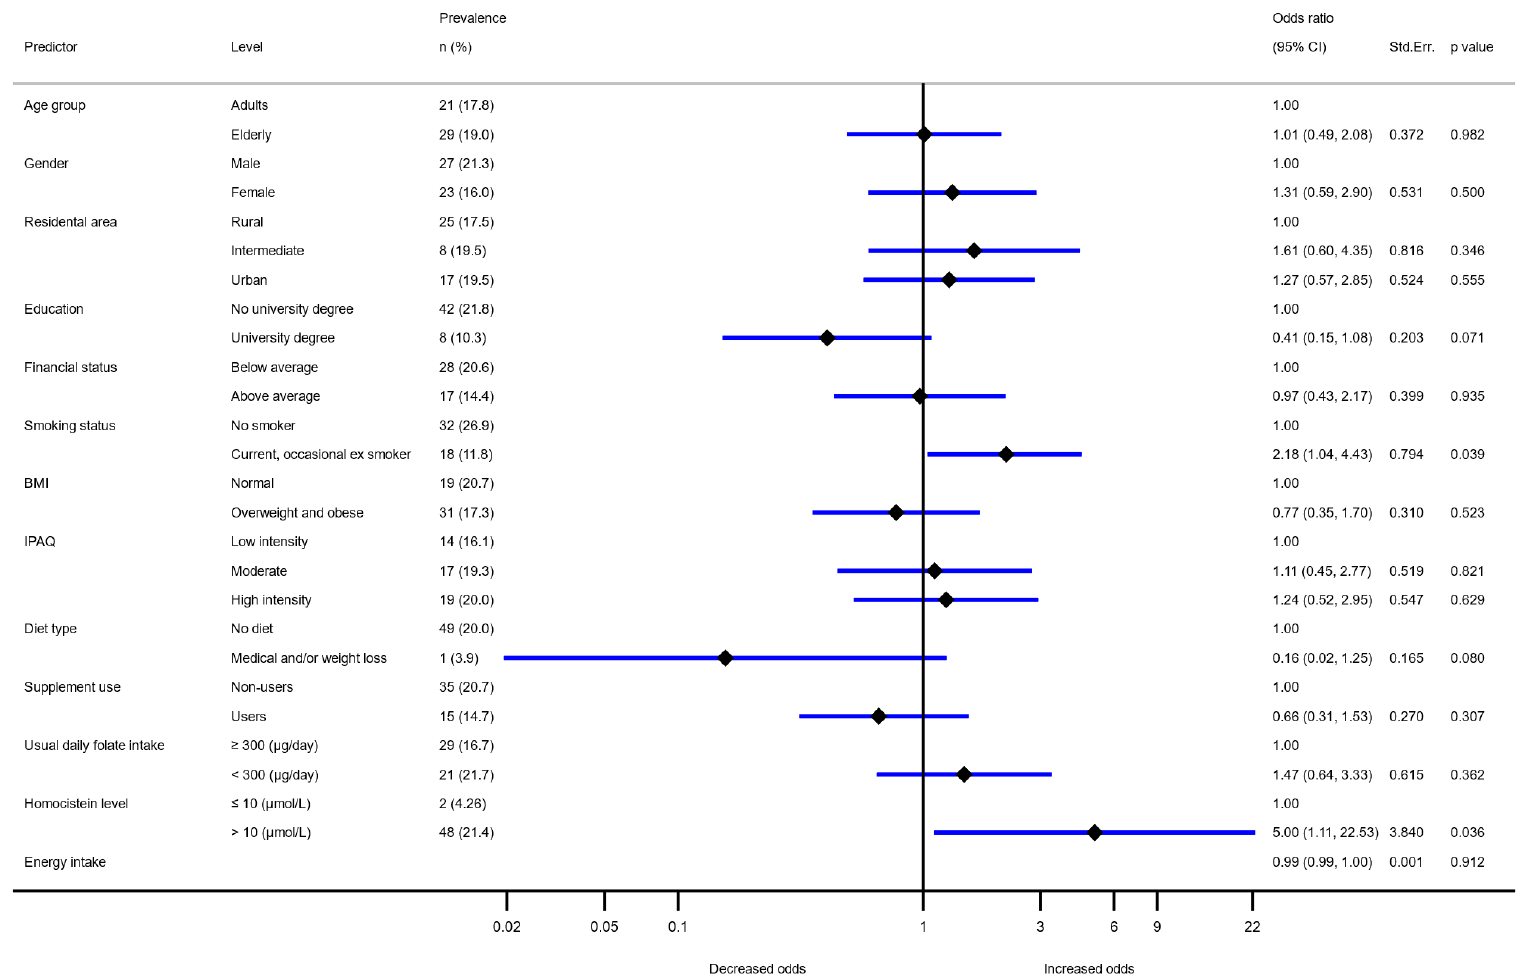
Figure 3. Association between serum folate concentration level (<7 nmol/L) and age, sex, residential area, education, family income, BMI (Body mass index), IPAQ (International Physical Activity Questionnaire) score, diet type, supplementation with multivitamins/folate, daily dietary folate intakes, and homocysteine status. Model adjusted for daily energy intake ( N = 271).